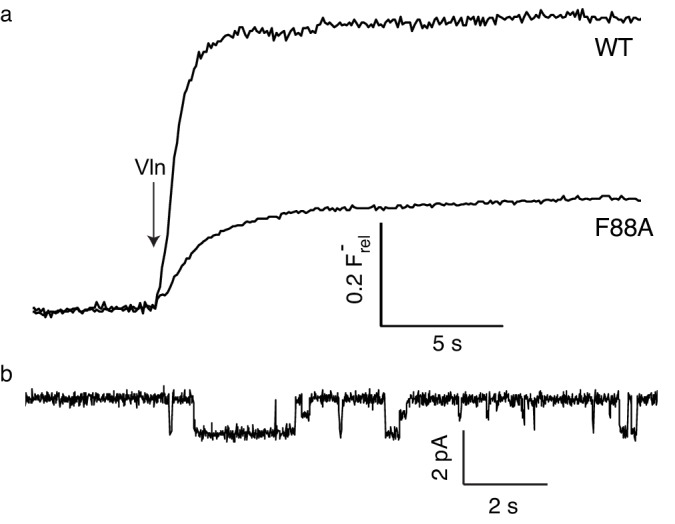
F- efflux (a) and single-channel recording (b) of F88A.